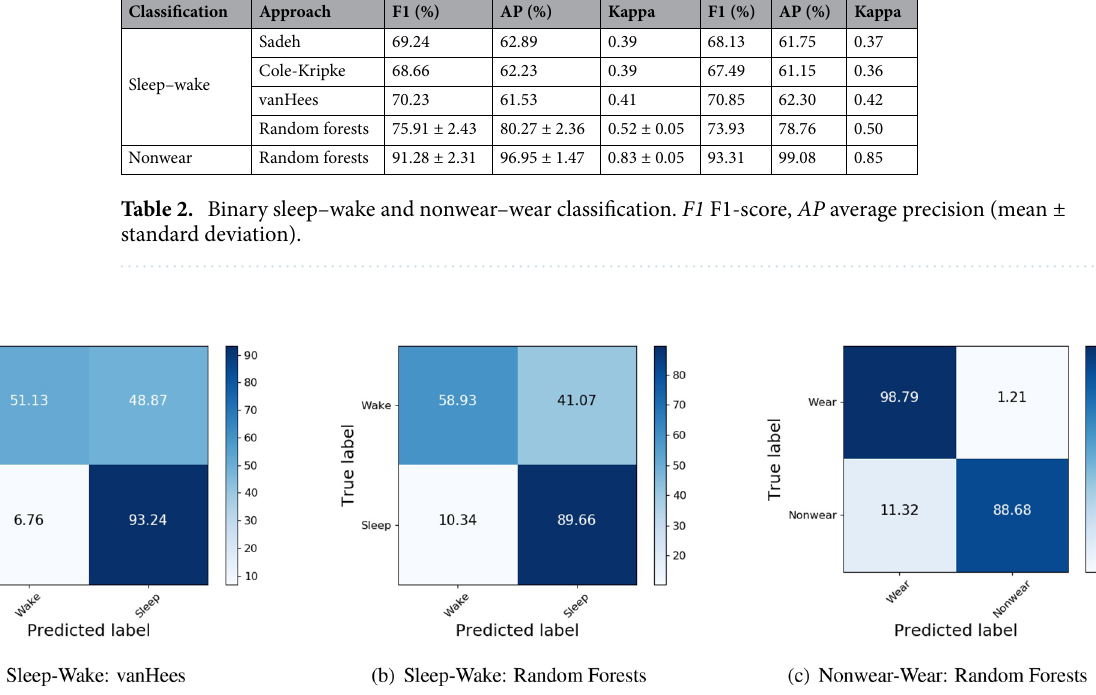
Figure 1. Sleep–wake and nonwear–wear classification on test set: confusion matrices for different methods. The numbers indicate the percentage of true labels that were predicted correctly or Random forests. The chosen hyperparameters for the trained random forests models for Sleep–Wake clas- sification for each of the five cross-validation folds are given as (trees, max-depth) tuple—(400,Full), (500,Full), (400,Full), (200,Full), (200,Full) where max-depth of Full implies that the decision trees are allowed to grow to any depth till termination criteria are satisfied. The classification performance metrics across the five outer folds are averaged and reported in Table 2 along with test set performance. It can be observed that the random forests approach outperforms the vanHees approach on both outer cross-validation and test data. Specifically, random forests perform better at detecting wakefulness compared to the vanHees approach as seen in the confusion matrices in Fig. 1, though the number of sleep–Wake samples is heavily imbalanced. The important features for sleep–wake classification averaged across all folds are shown in Supplementary Information Figure 4. For more information on feature definition see METHODS section. It can be observed that statistical measures for Locomotor Inactivity During Sleep (LIDS) and Z-angle are the most important features for sleep-wake classification. Healthy versus poor sleepers. Figure 2 shows the plots of F1-score with respect to time spent sleeping for each user based on whether they are poor or healthy sleepers. Red markers denote F1-scores of sleep and green mark- ers denote F1-scores of wakefulness for each user. We obtained the Spearman’s correlation coefficient for the time spent sleeping and F1-scores for healthy and poor sleepers. For healthy sleepers, it was observed that wake- fulness F1-scores and time spent sleeping were negatively correlated due to fewer wake samples causing poor wakefulness classification. For poor sleepers, time spent sleeping was positively correlated with sleep F1-scores and negatively correlated with wakefulness F1-scores.